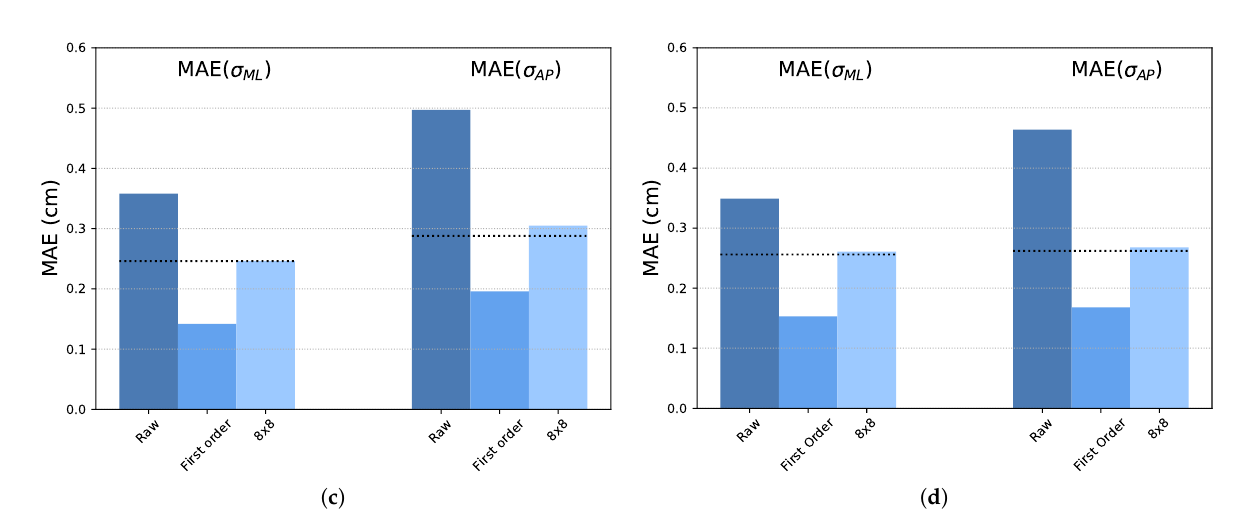
Figure 5. ICC and MAE for different processing conditions. ( a ) ICC, RL trial; ( b ) ICC, LL trial; ( c ) MAE, RL trial; ( d ) MAE, LL trial. Dotted horizontal lines, level of base processing for comparison